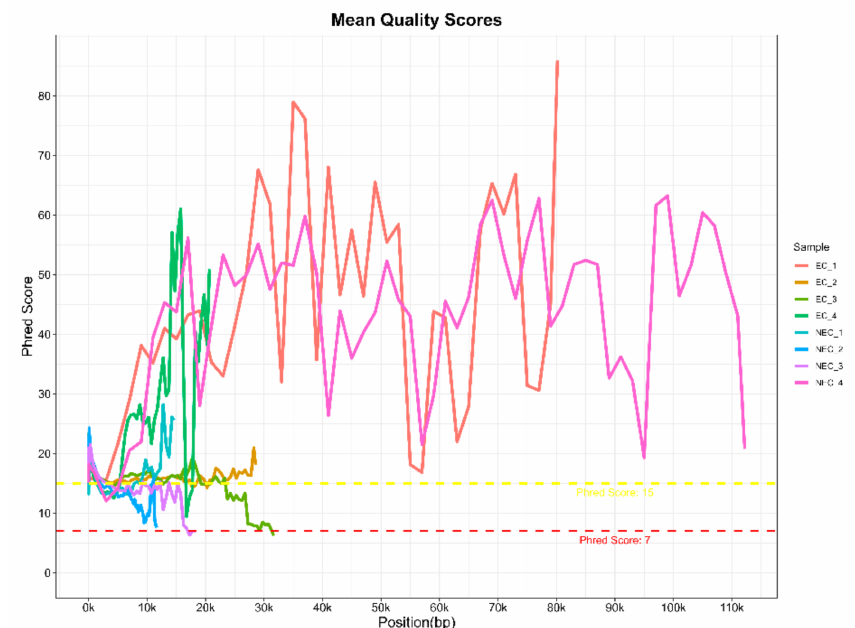
Figure 4. Raw data quality assessment of long-reads generated from barcoded cDNA libraries of S. betaceum compact embryogenic callus (EC) and friable non-embryogenic callus (NEC) by